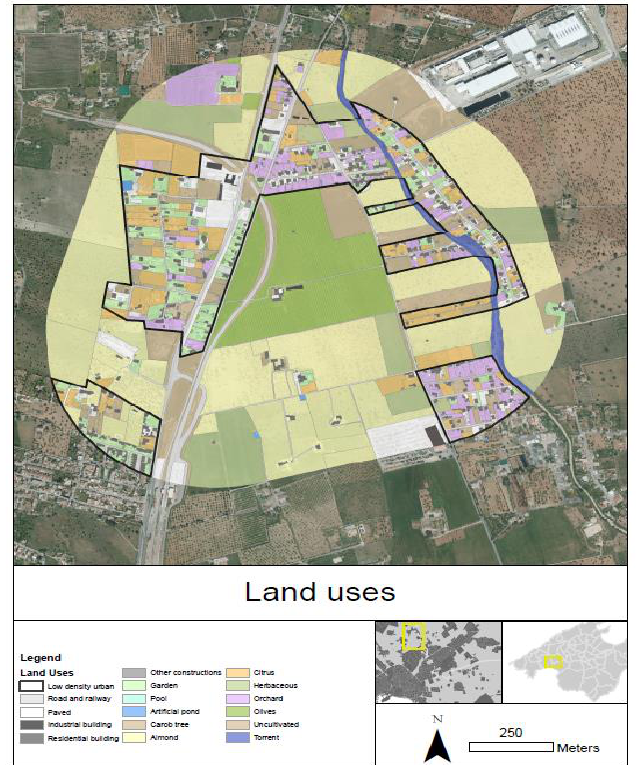
Figure 2. Categories of land use in the surroundings of the selected orchard for the pilot